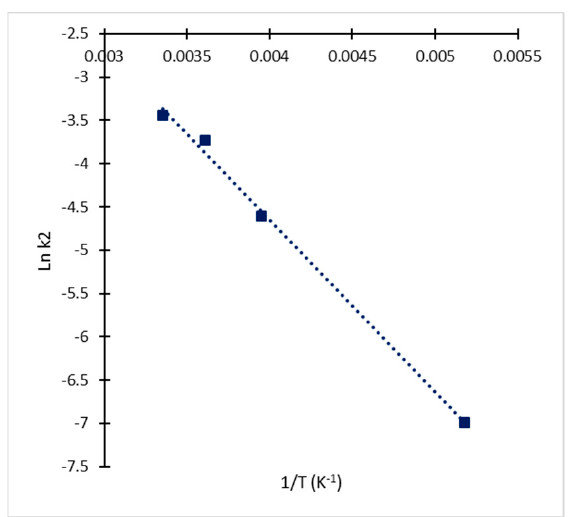
Figure 5. Arrhenius plot for determination of kinetic parameters (E a and A) for the irreversible reaction